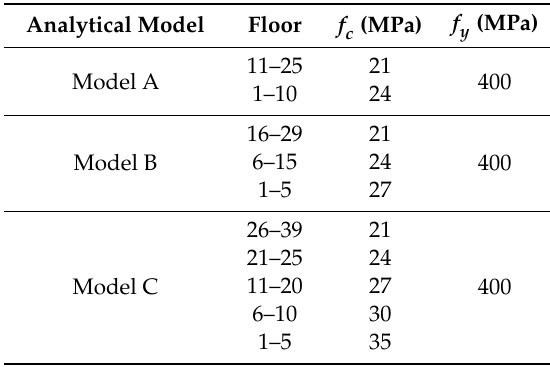
Table 3. Material property of analytical